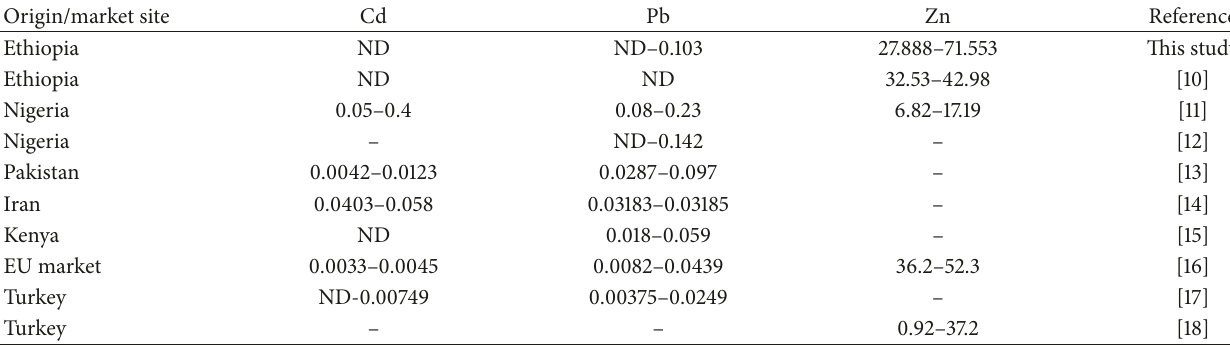
Table 2: A comparison of metals levels (mg/kg) in infant formulas with reported data in the literature.